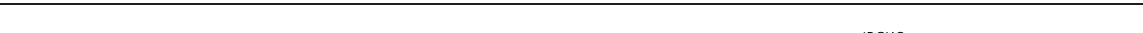
Fig. 3 Lung phenotype of PC-speci fi c Yap1,Wwtr1 mutants. a Maximum intensity projections of P7 and P12 Yap1 , Wwtr1 iPCKO and littermate control lungs showing NKX2.1-stained (green) AT1 and AT2 cell nuclei, LAMP3-stained AT2 cells (red), and DAPI (blue). Scale bar, 30 µ m. b Quantitation of NKX2.1 positive and LAMP3 positive cells shown in a . Data represents mean ± s.e.m. ( n = 4 mice; two-tailed unpaired t -test or Welch ’ s t -test). c Three dimensional high magni fi cation reconstruction images of Yap1 , Wwtr1 iPCKO R26-mT/mG and littermate control lungs stained for GFP (white). Scale bar, 20 µ m. d Flow cytometric analysis of PDGFR β + pericytes in P12 Yap1 , Wwtr1 iPCKO and control lungs. Data represents mean ± s.e.m. ( n = 7 mice; NS not signi fi cant, two- tailed unpaired t -test). e , f Confocal images of P12 Yap1 , Wwtr1 iPCKO and littermate control lungs stained for PECAM1 (white). Note formation of capillaries at the secondary septa in controls (arrowheads) but not in mutants. Panels in f show higher magni fi cation of insets in e . Scale bar, 20 µ m ( e ) and 10 µ m ( f ). g Three-dimensional high magni fi cation reconstruction images of P12 Yap1 , Wwtr1 iPCKO and littermate control lungs stained for ERG (green), ICAM2 (red), and DAPI (blue). Scale bar, 30 µ m. h Quantitation of ICAM2-stained vascular density based on 3D reconstruction surface images, as shown in g . Data represents mean ± s.e.m. ( n = 4 mice; unpaired two tailed student t -test) i Maximum intensity projections of P7 Yap1 , Wwtr1 iPCKO and littermate control lungs stained for α SMA (red) and tropoelastin (blue). Scale bar, 100 µ m. j Quantitation of staining intensity for α SMA or tropoelastin shown in i . Signal intensity was normalized to the size of the parenchymal region. Data represents mean ± s.e.m. ( n = 4 mice; NS not signi fi cant, two-tailed unpaired t -test). k Western blot analysis of α SMA and tropoelastin in P7 Yap1 , Wwtr1 iPCKO and littermate control total lung lysates ( n = 3 mice). Molecular weight marker (kDa) is